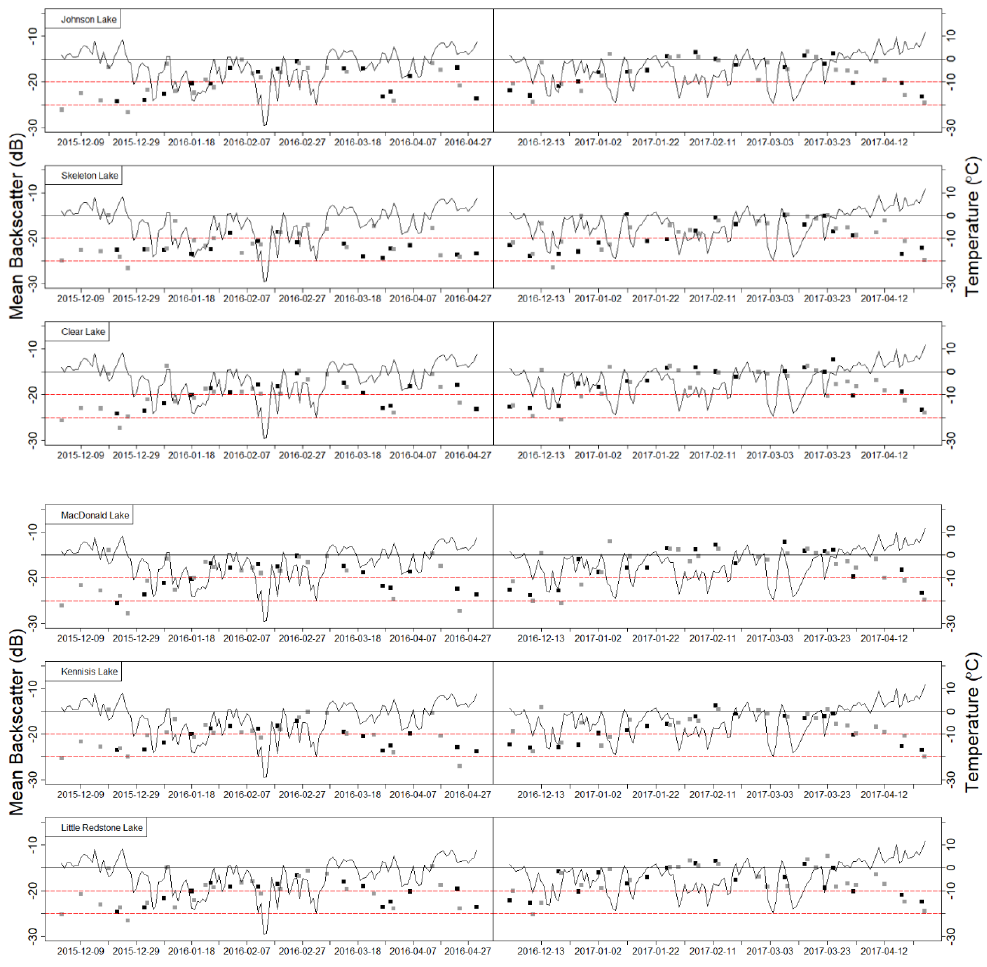
Figure 3. Mean backscatter evolution for six of the major study lakes in Central Ontario. Black squares represent images that were acquired in the PM and grey squares represent images acquired in the AM. The black line represents daily mean temperatures and the solid line is 0 °Celsius. The dotted red lines represent a range of backscatter between −20 and −25 dB. Data for other ice seasons were obtained but are not shown.